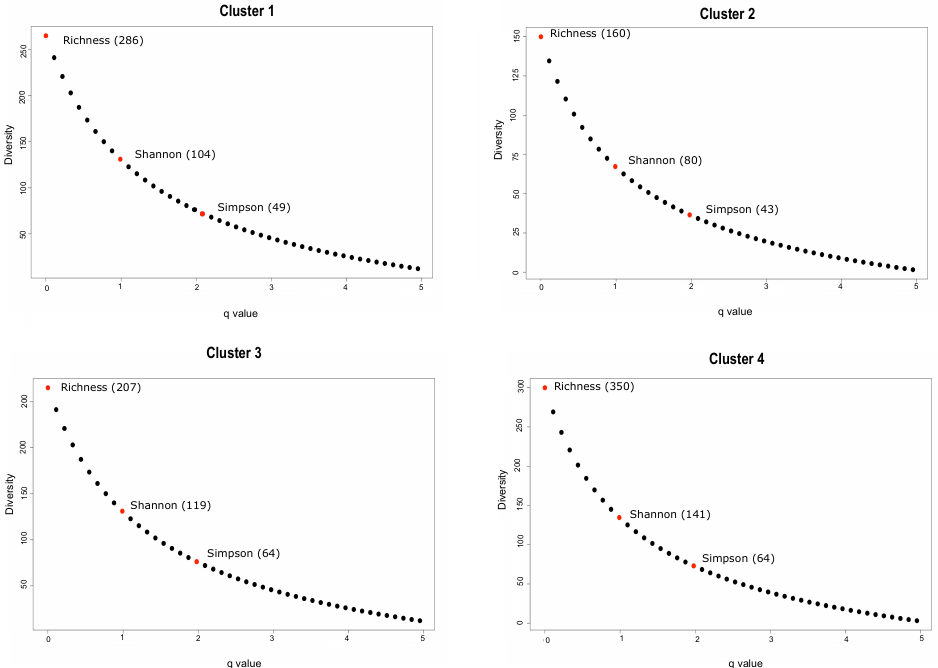
Figure 4. Effective number of species based on richness (q0), evenness (q1 = Shannon) and dominance (q2 = Simpson) across different clusters. The effective number of species are shown in parentheses.